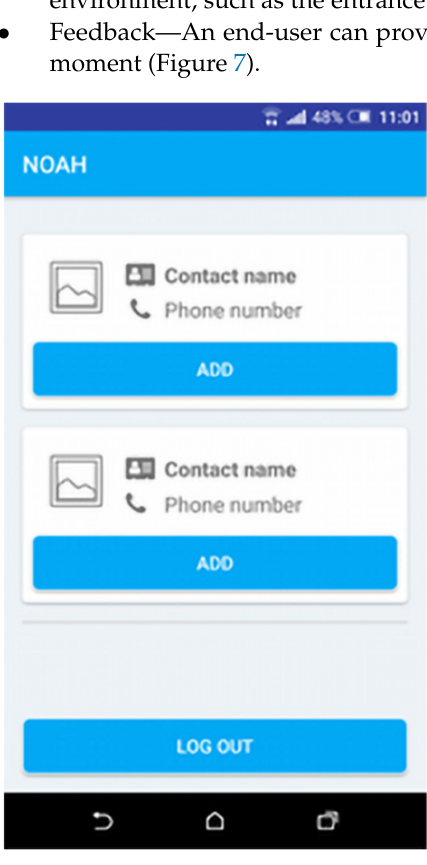
Figure 5. Contacts